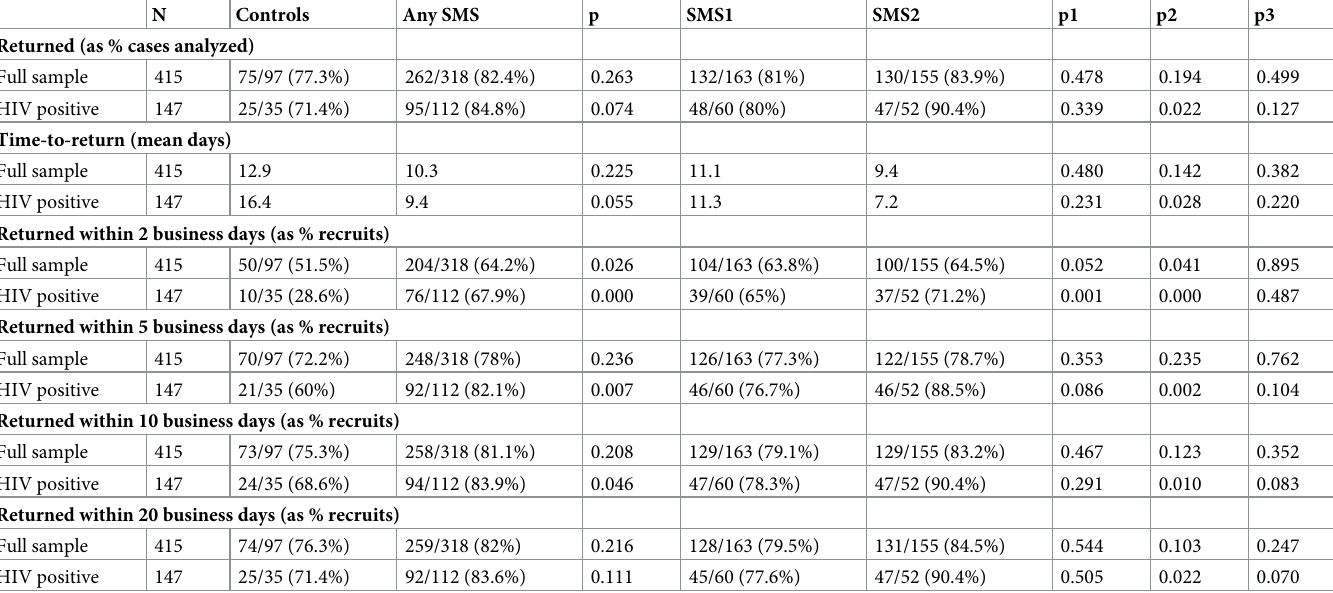
Table 3. Per-protocol results.